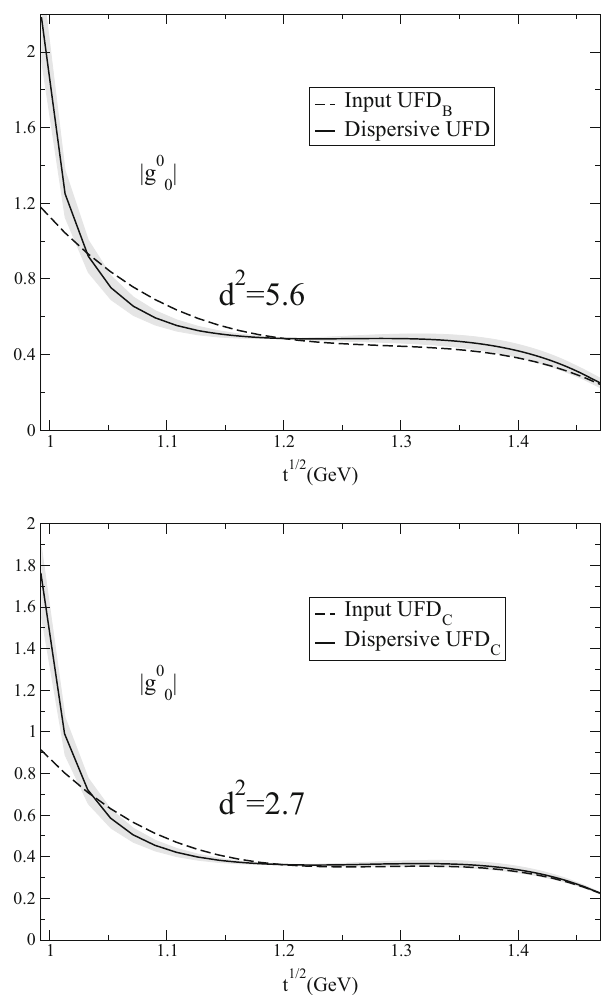
Fig. 7 Comparison between the input (dashed line) and the dispersive output (continuous line) for the modulus of the g 0 in Eq. (45). In the upper panel we show the results using as input the UFD B parameterization and in the lower panel those from the UFD C . Thegraybandscovertheuncertaintyofthedifferencebetweentheinput and the respective dispersive